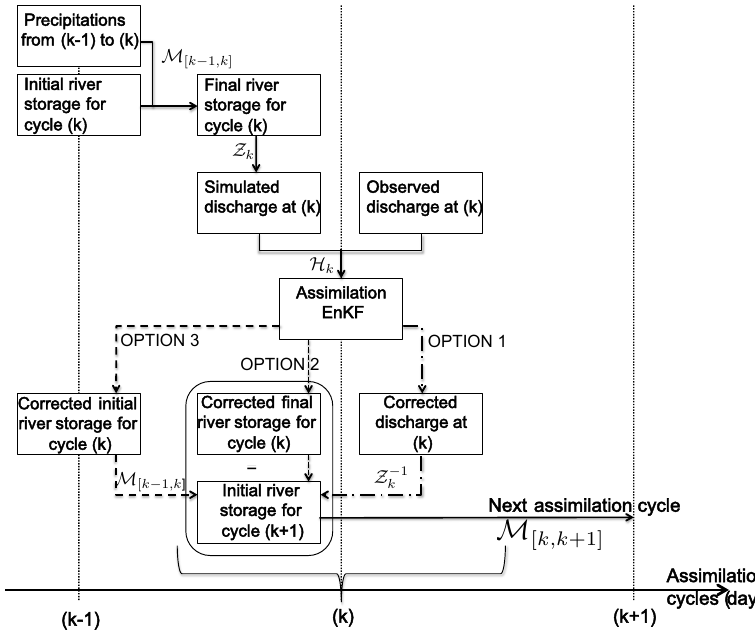
Figure 3. General framework of the DA method at a k th assimilation cycle. The figure reads from top to bottom and from left to right. The three main variables involved are the river initial storage, the river final storage and the river discharge. M [ k − 1 ,k ] is the model operator that maps the initial river storage into final river storage, Z k is the diagnostic operator and H k is the observation operator that maps simulated discharge into observed discharge for